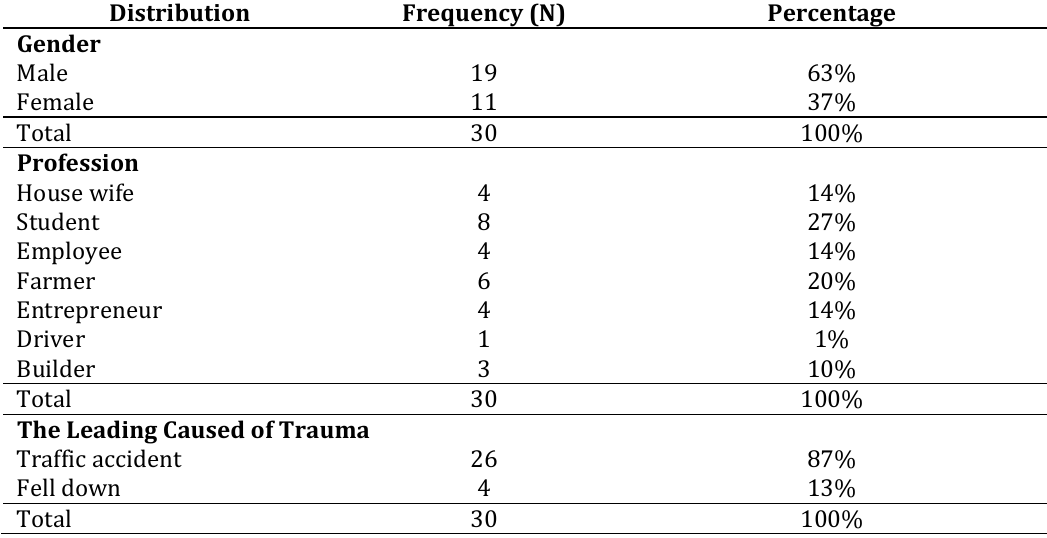
The characteristics distribution of the study participant Distribution